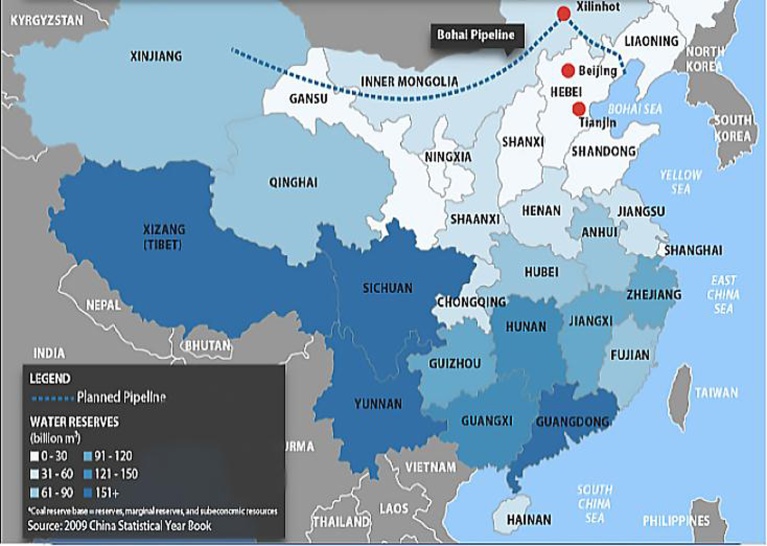
Water Reserves in China. Source: China Statistical Yearbook (2009).